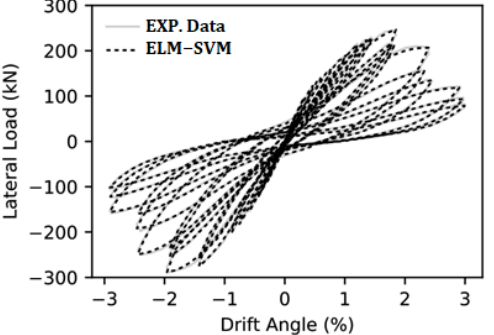
Figure 5. Lateral loads against drift ratio of the outside concrete beam − column connection of the plane multi − story concrete and comparing the results of experimental [31] with the ELM − SVM method results.